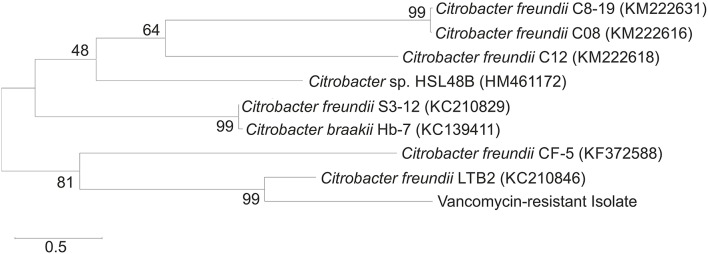
Neighbor-joining phylogenetic tree of the bacteria based on comparisons of the 16S rRNA gene sequences. Bootstrap values from 1000 replications are indicated at the branches. GenBank accession numbers are given in parentheses.